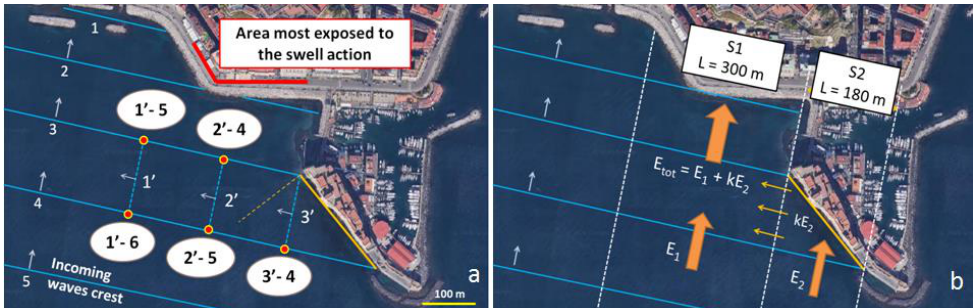
Figure 18. Complex scenario of wave motion in front of Via Partenope, due to the reflection of incident waves on the western bastion of Castel dell’Ovo. Reflected waves are indicated with dotted light blu lines 1′-2′-3′ ( a ). ( b ) The energy flux reflected by Castel dell’Ovo, enhances the wave energy impacting Via Partenope. Equation indications are from Equation (20).